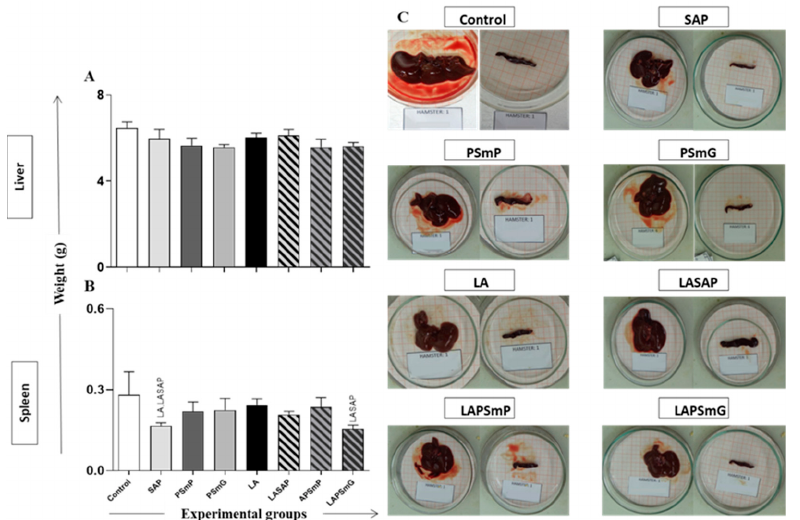
Figure 3. Liver ( A ) and spleen ( B ) weights were measured immediately after euthanasia (T180) and are represented as mean ± standard deviation. ( C ) Contains the representative image of the organs (liver—left side and spleen—right side) of each group. The statistical difference ( p < 0.05) was represented by the acronyms of the corresponding group. Legend: C: control; SAP: saponin; PSmP: small empty submicron particle; PSmG: large empty submicron particle; LA: L . amazonensis crude antigen; LASAP: L . amazonensis crude antigen associated with saponin; LAPSmP: small submicron particle associated with L . amazonensis ; LAPSmG: large submicron particle associated with L . amazonensis . Data from the qPCR analysis showed that LAPSmP and LAPSmG were the only groups with a marked reduction in the splenic parasite load ( p < 0.01; p < 0.05, respectively)